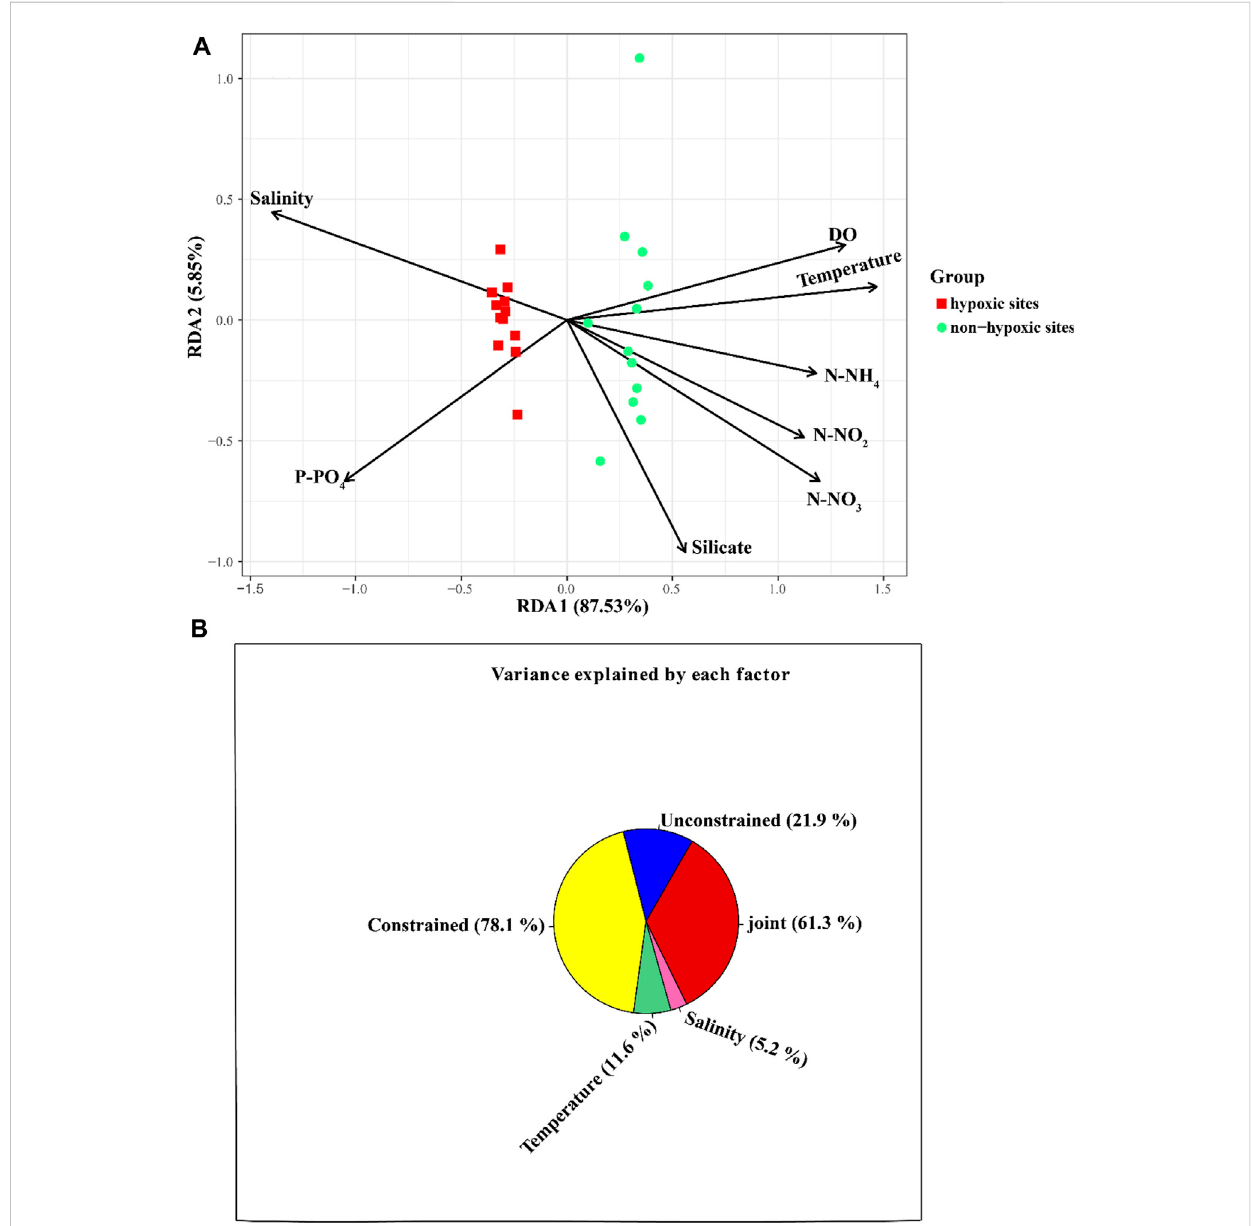
FIGURE 8 Relationship between environmental factors and archaeal community at the OTU level. (A) RDA showing the relationship between environmental variables and archaeal community in the Changjiang Estuary. (B) VPA analysis for contribution of environmental factors to archaeal